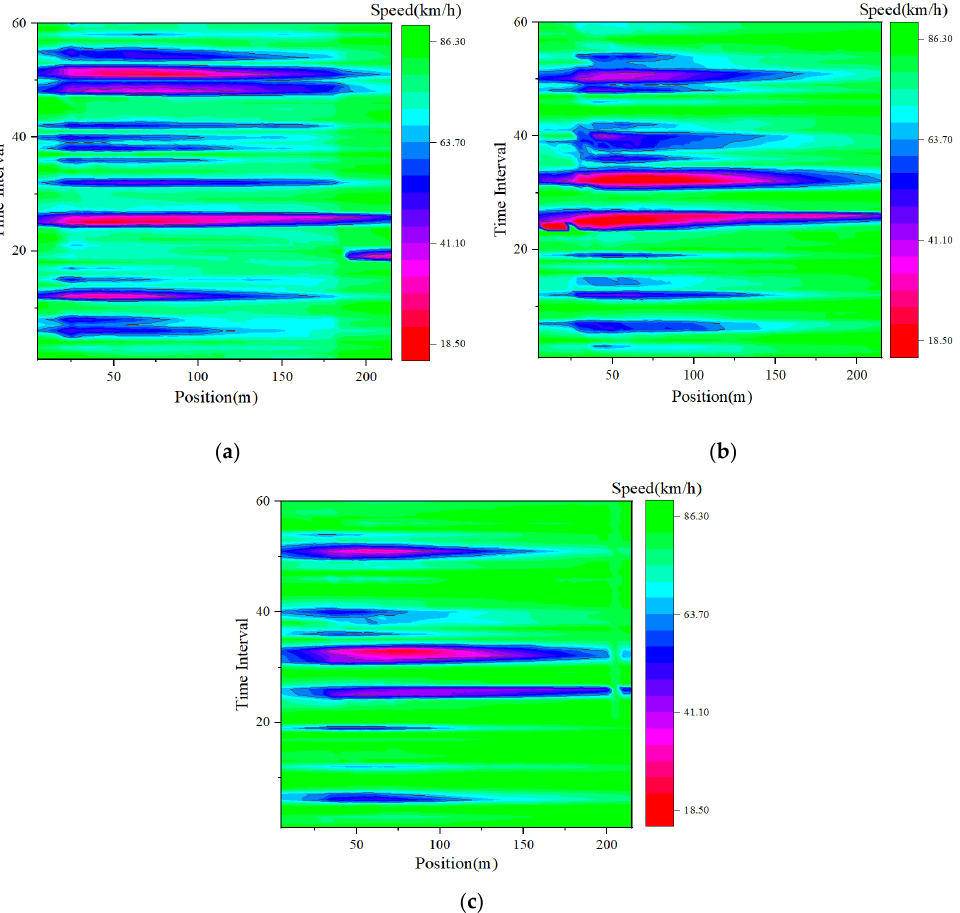
Figure 10. Temporal and spatial distributions of traffic flow state. ( a ) Outer lane; ( b ) Middle lane; ( c ) Inner